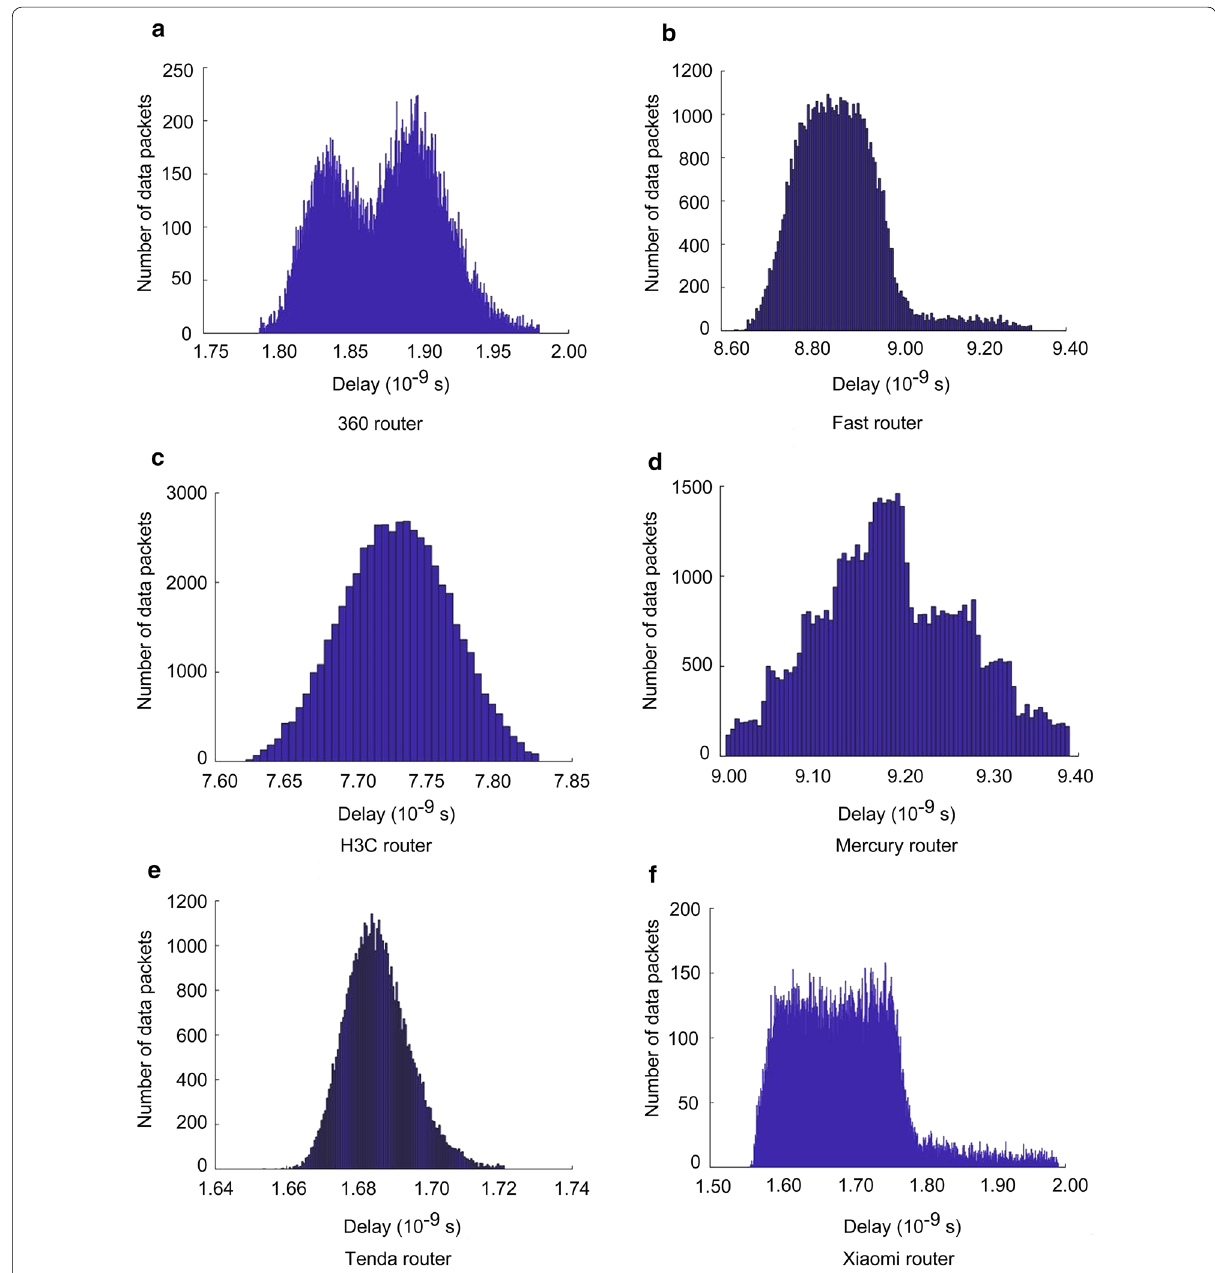
Fig. 3 The delay distribution of the six different